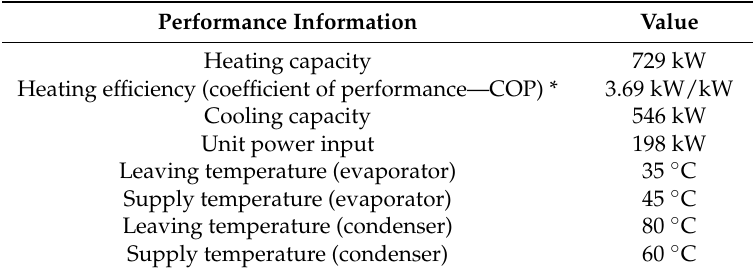
Table 3. Main design parameters of the selected heat pump.